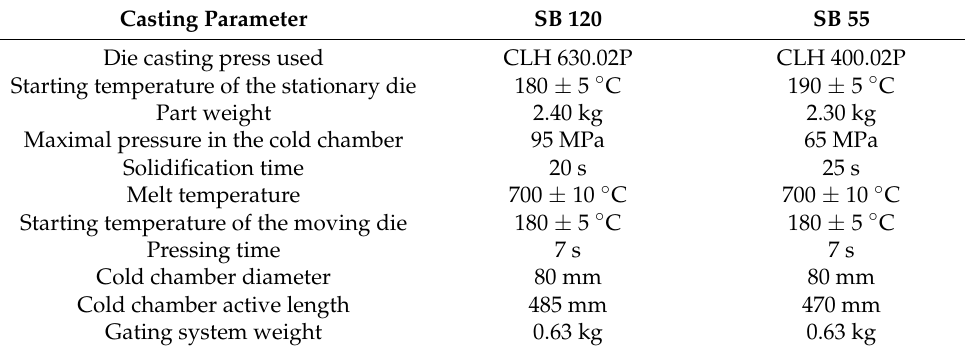
Table 2. Casting parameters of the SB 120 and SB 55 parts.